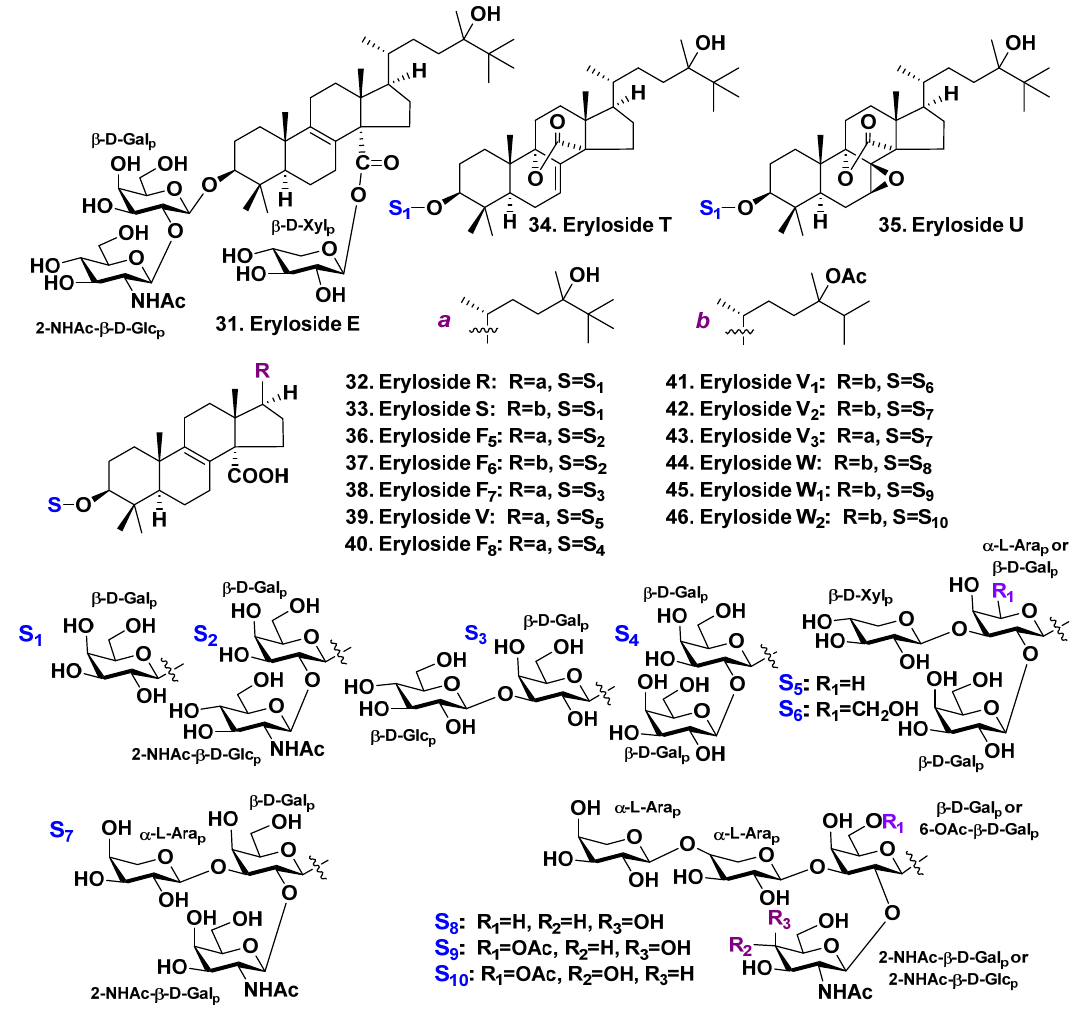
Figure 3. Erylosides 31 – 46 from Erylus goffrilleri .